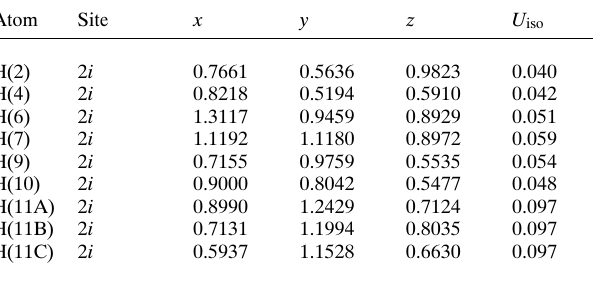
Table 2. Atomic coordinates and displacement parameters (in Å 2 )